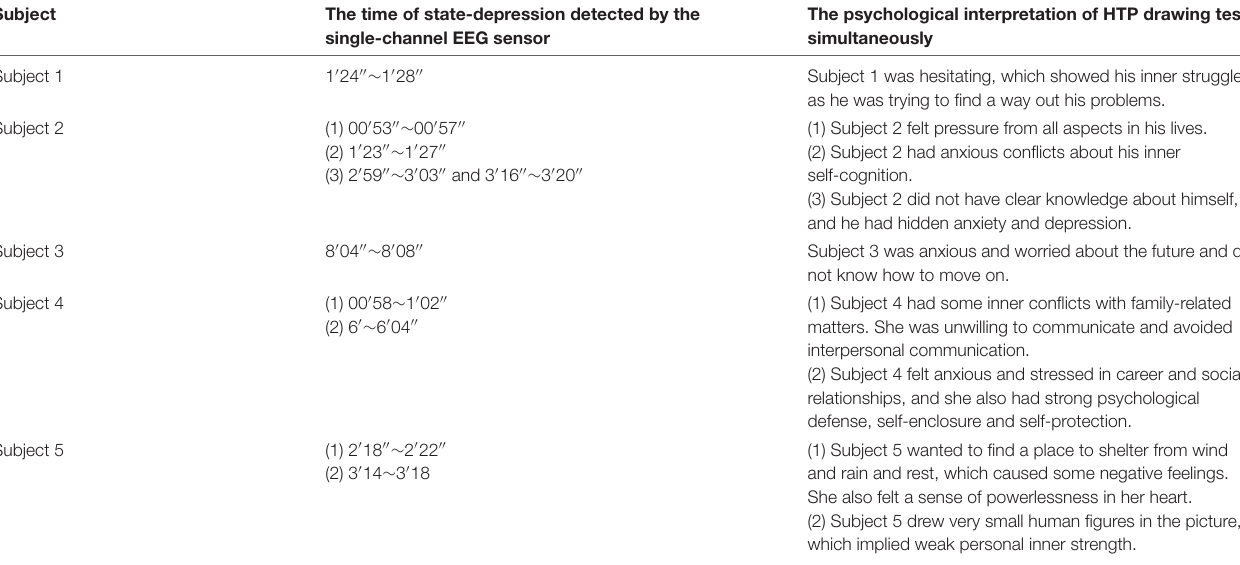
TABLE 2 | Examples of the depressive thoughts/feelings of subjects and the corresponding depressive EEG